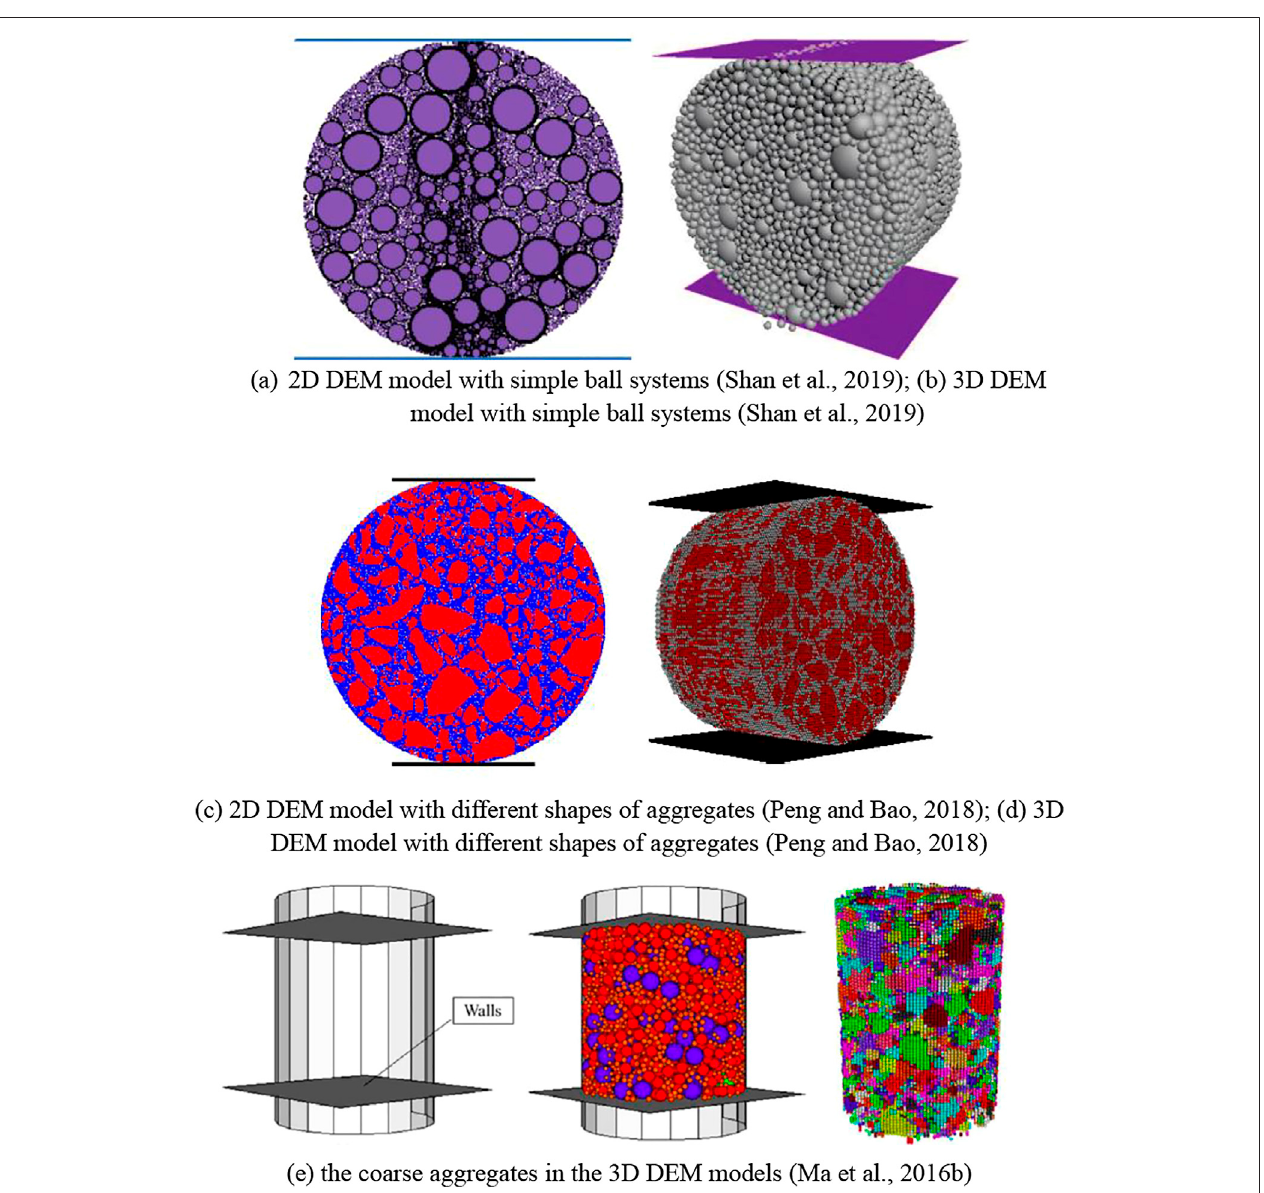
FIGURE12| 2Dand3DDEMsimulationsforthesplittingtest(indirecttensiletest)oftheasphaltmixtures(Shanetal.,2019;PengandBao,2018;Maetal.,2016b). (A) 2DDEMmodelwithsimpleballsystems(Shanetal.,2019); (B) 3DDEMmodelwithsimpleballsystems(Shanetal.,2019). (C) 2DDEMmodelwithdifferentshapesof aggregates(Peng and Bao, 2018); (D) 3D DEM model with different shapes of aggregates(Peng and Bao, 2018). (E) the coarse aggregates in the 3D DEM models (Ma et al., 2016b).